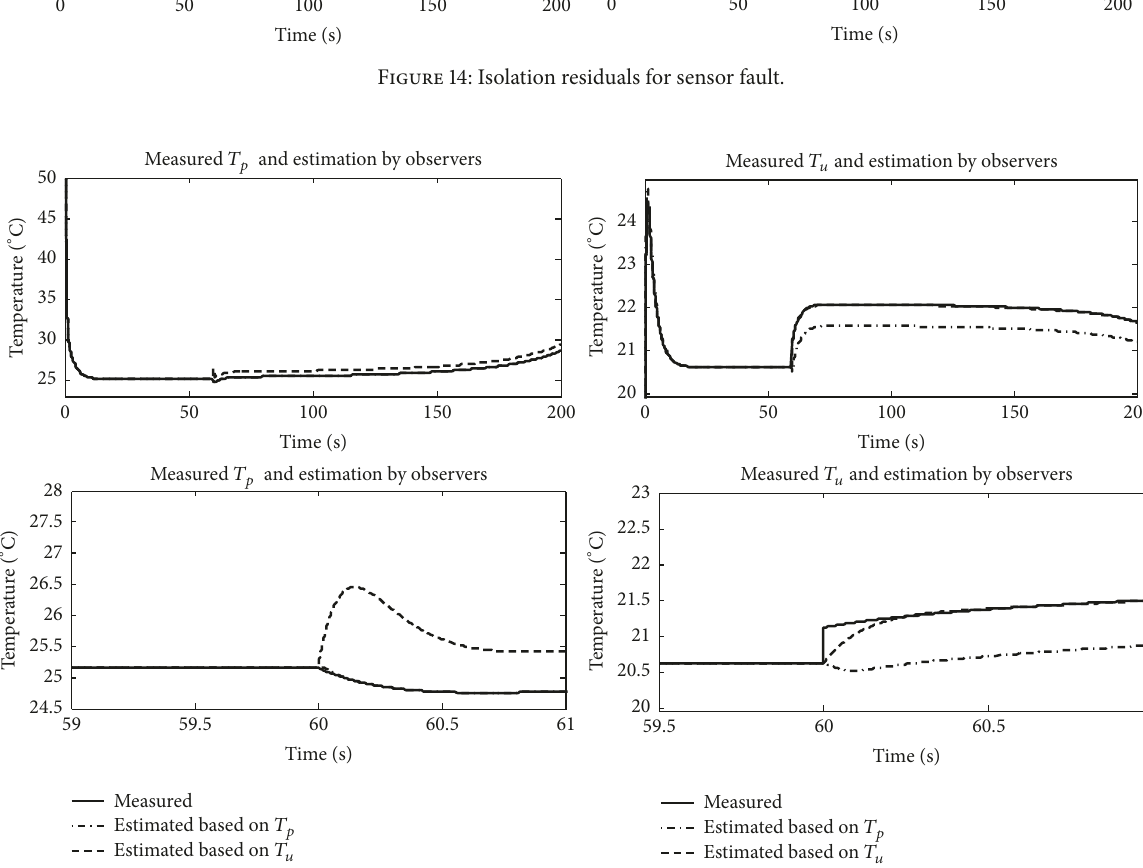
Figure 15: Temperature output by sensors and